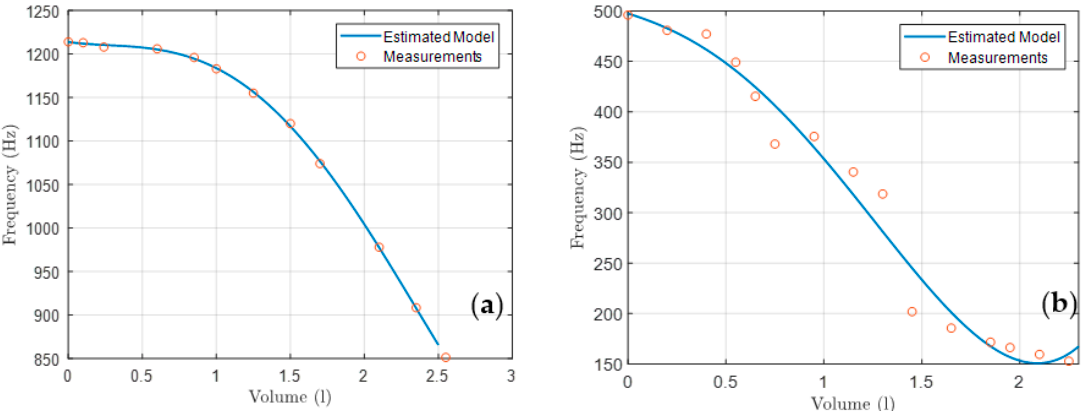
Figure 14. Measures over different materials: ( a ) Measurements for the aluminum tank. ( b ) Results for the polypropylene tank (blue line: model; dots: measured data).